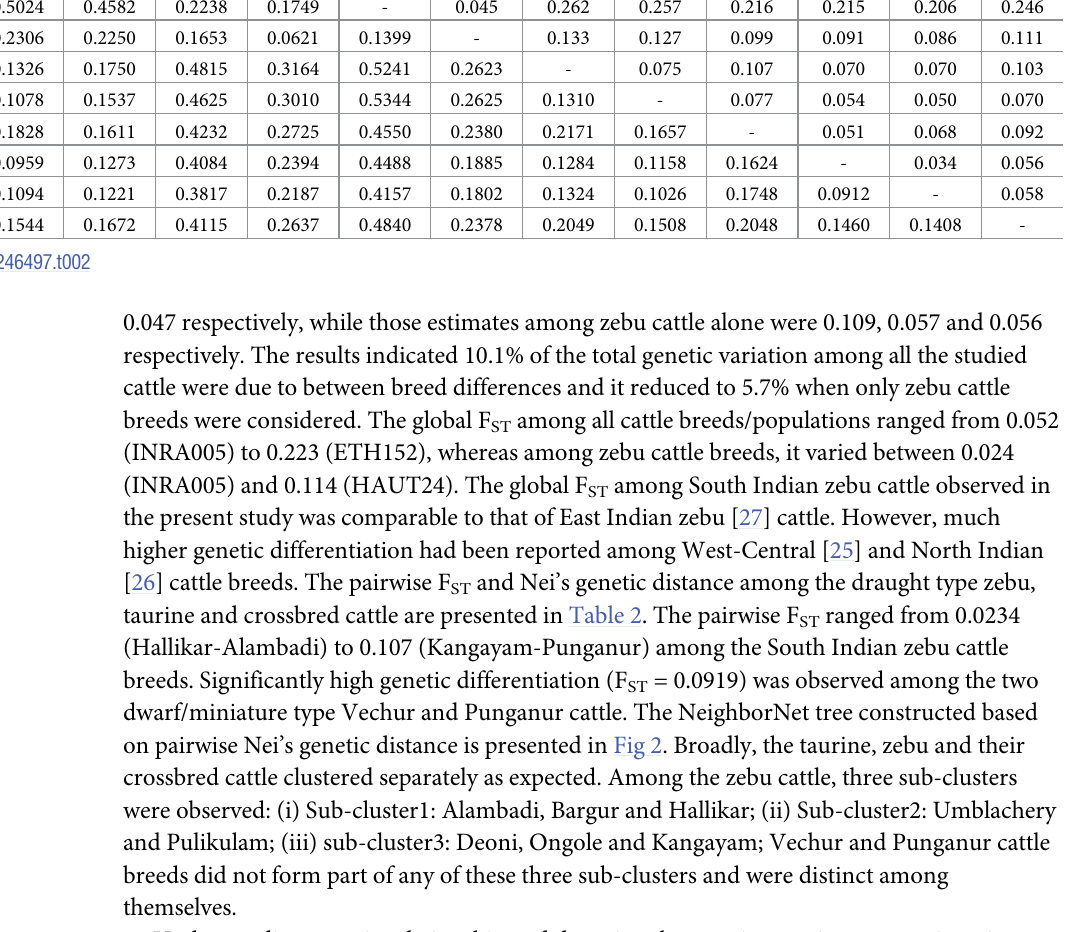
Table 2. Pairwise F ST (upper triangle) and pairwise Nei’s genetic distance (lower triangle) among draught type zebu, taurine and crossbred cattle from South